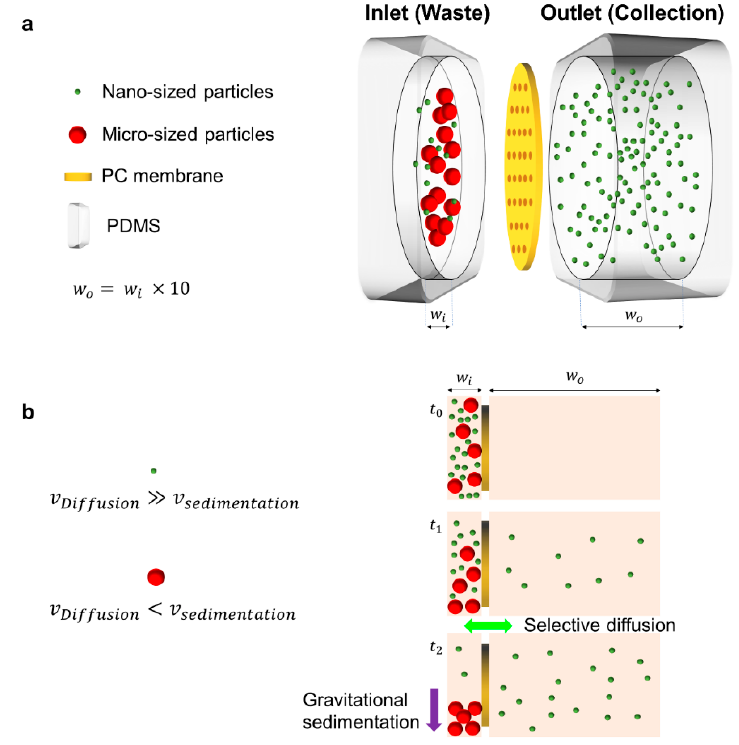
Figure 1. Schematic of the nanoporous PC membrane chip and its principle. ( a ) The chip is composed of a PC membrane with a diameter of 25 mm and two PDMS chambers that are inlet and outlet, respectively. PC membrane with a pore size of 200 nm is located vertically between the two chambers. The width of the outlet chamber (w o = 5 mm) was designed to be 10 times larger than the width of the inlet chamber (w i = 500 µ m). ( b ) Nano-sized (shown in green color) and micro-sized (shown in red color) biomolecules show dominant movement of diffusion and sedimentation, respectively.